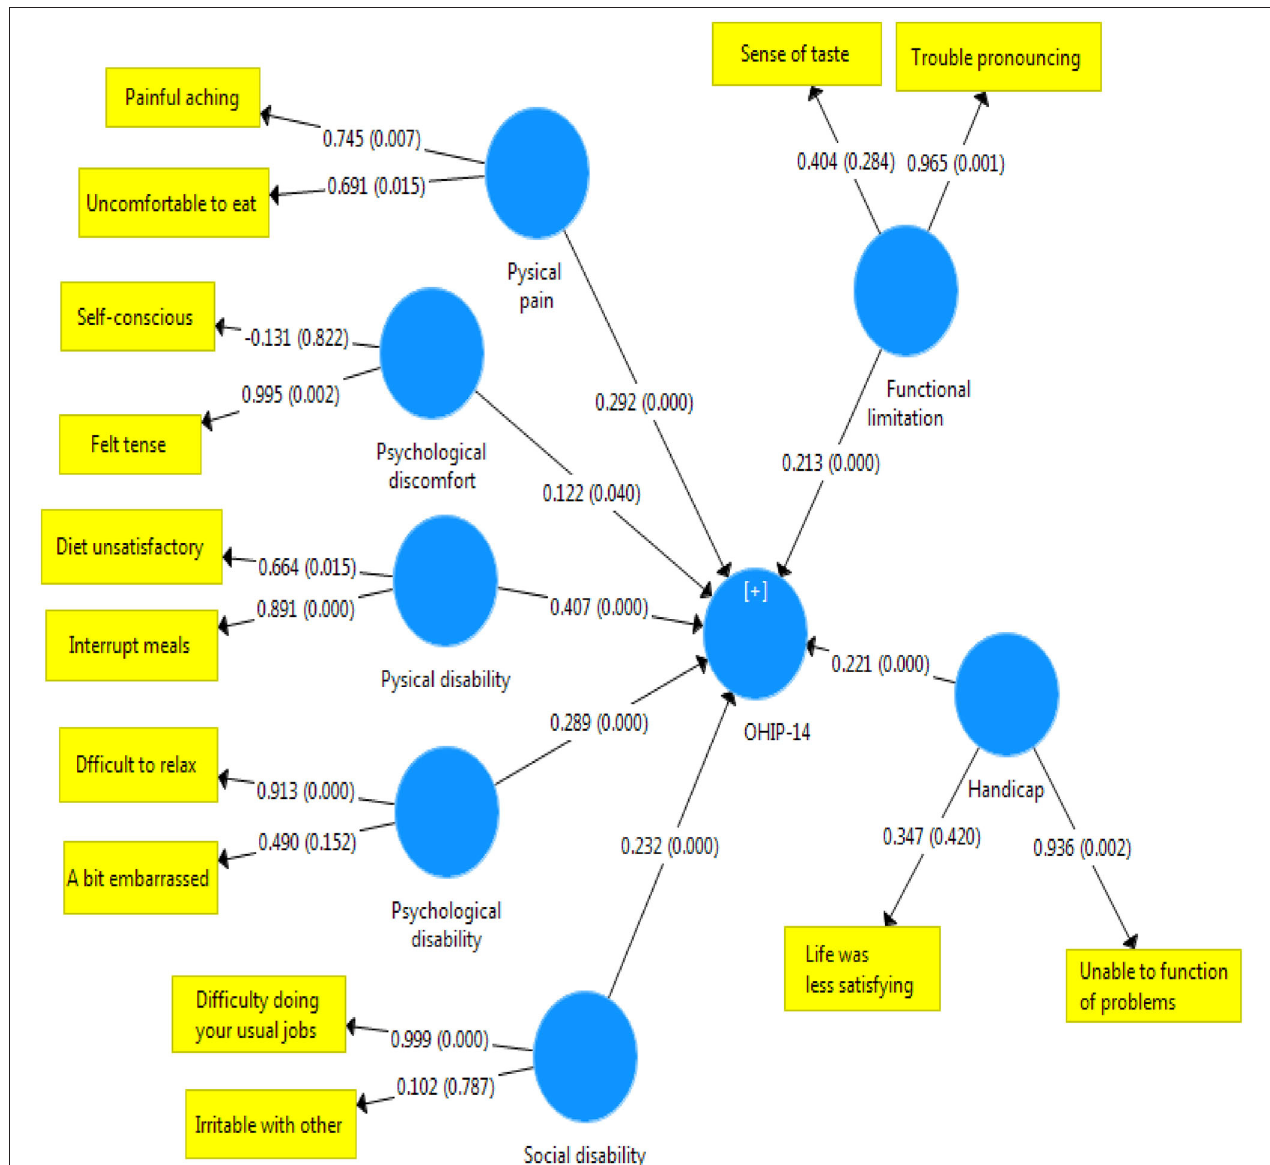
FIGURE 3 | Status and severity of the relationship between scores in the dimensions of OHIP-14 scale and the total score of quality of life related to oral health in narcotic and stimulant